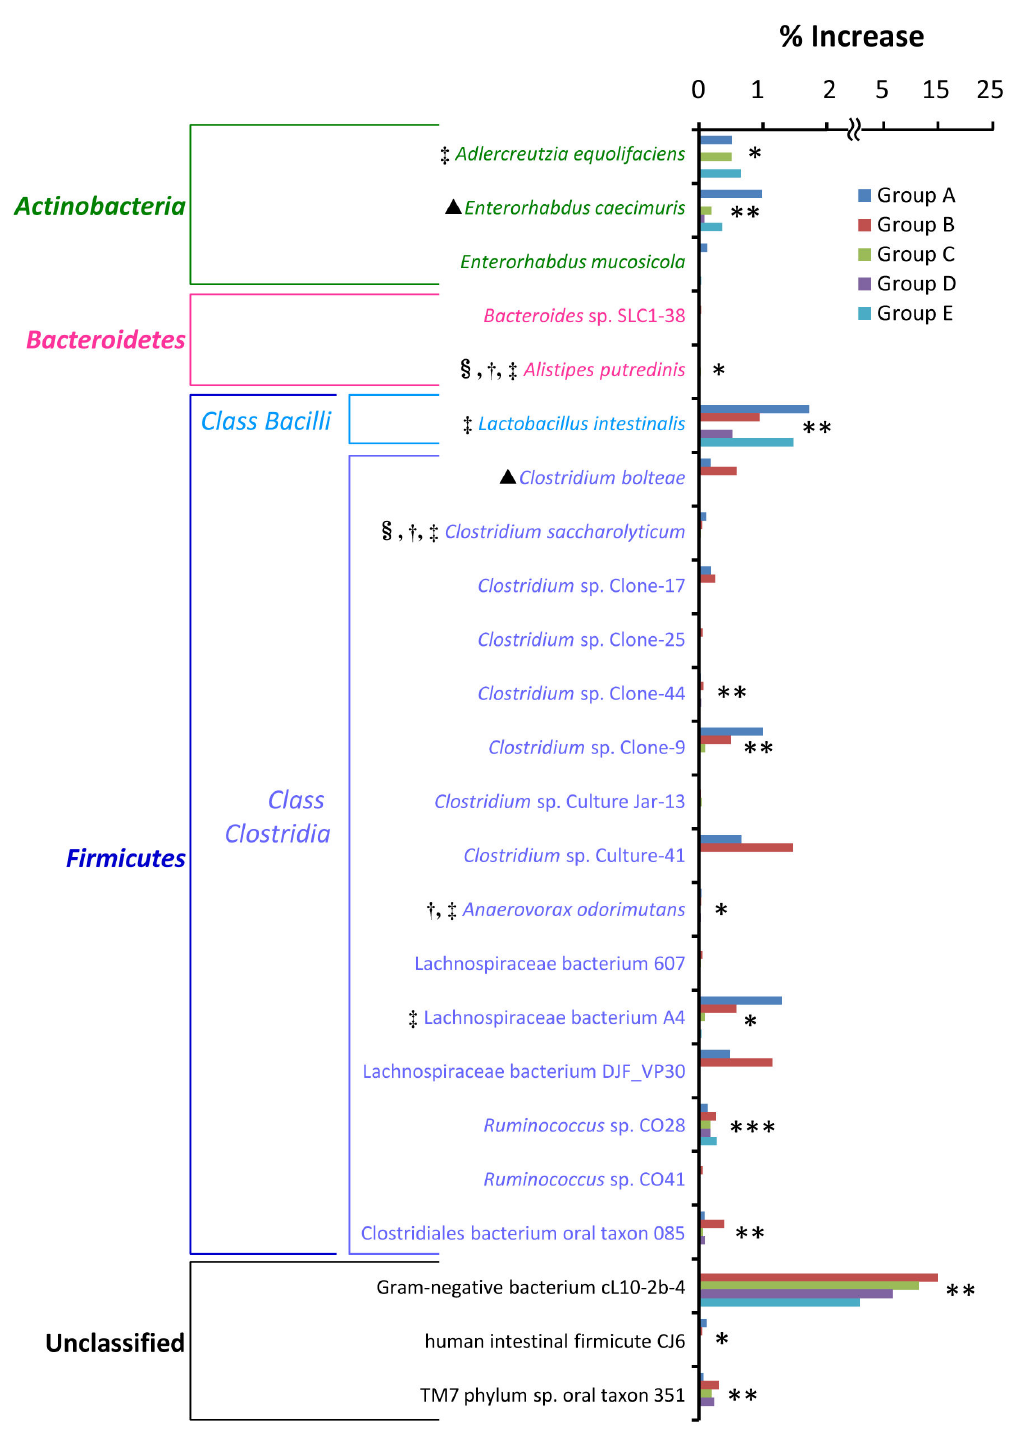
Figure 3. Bacterial phylotypes in the small intestine whose population level increased upon PG-administration. Percent increase was calculated by subtracting the percent population level of each specific phylotype found in the PG-administered mice with that found in the PBS control mice. Associations between bacterial phylotypes and PG administration were examined by Fisher exact test. The phylotypes having P values less than 0.05 at least in 2 groups (see Table S6) are shown. Asterisks *, ** and *** indicate bacterial phylotypes having P values less than 0.05 in 3, 4 and 5 groups, respectively. §: Saccharolytic bacteria, †: short- chain fatty acids-producing bacteria, ‡: bacteria with immunomodulatory effect, ▲: disease-associated bacteria. doi: 10.1371/journal.pone.0075008.g003 PLOS ONE |